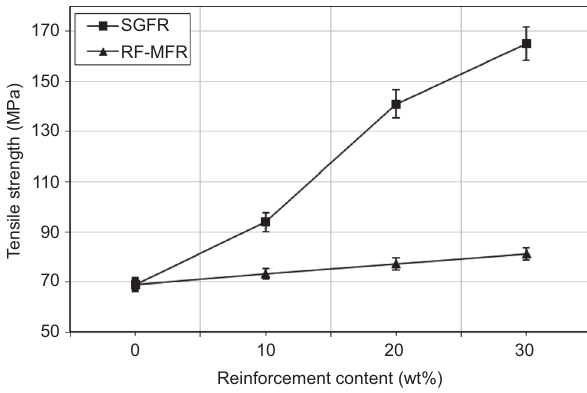
Figure 1 Variation of the tensile strength of PA6 with weight percent of reinforcement content.